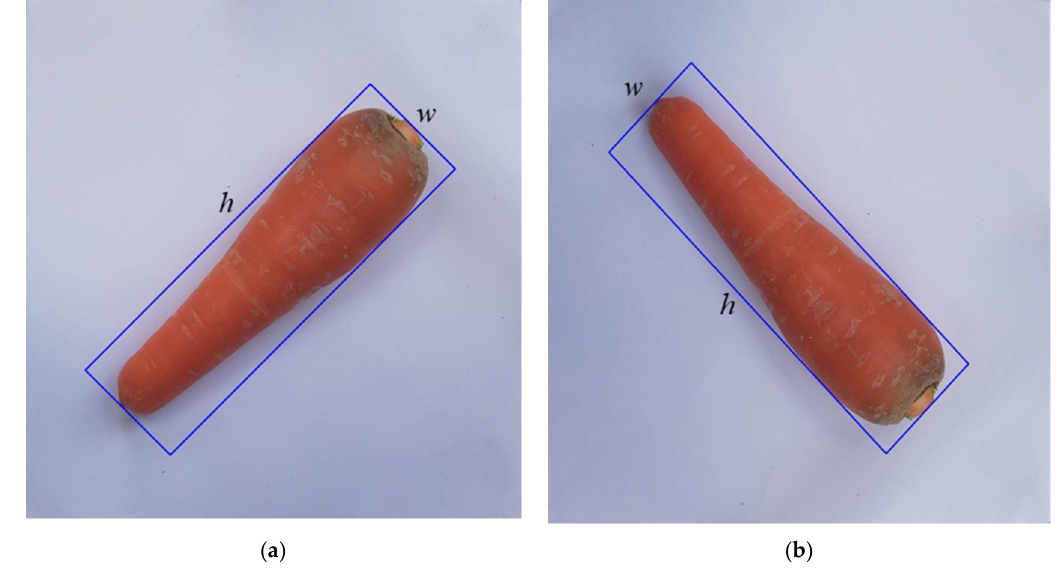
Figure 11. Bounding box on a carrot rotated in different angles. ( a ) 45° and ( b ) 135°